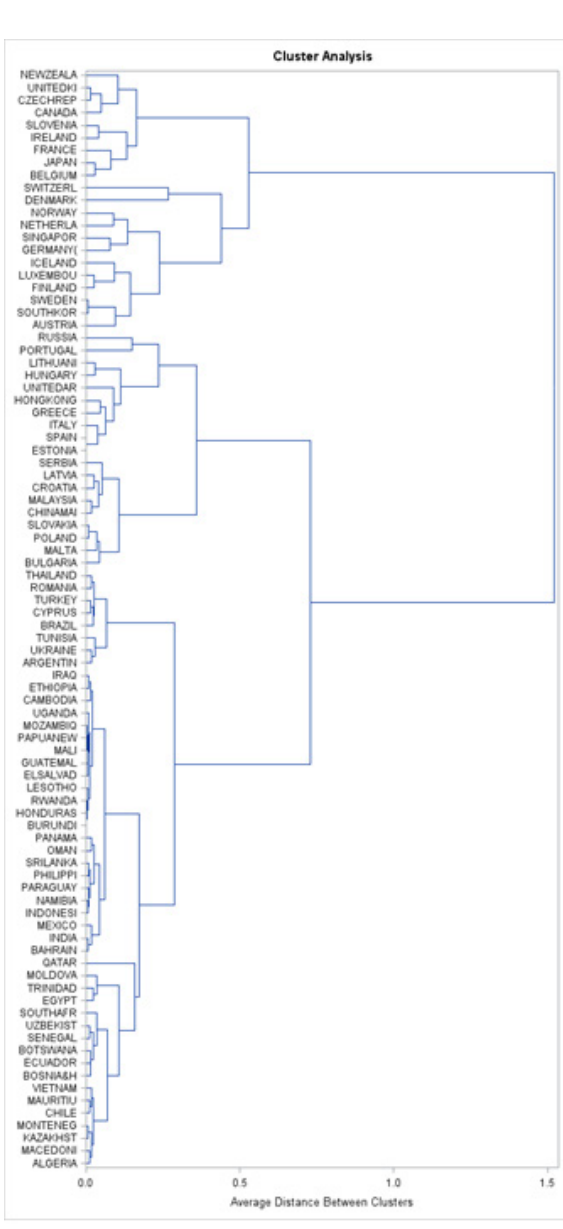
Figure 3. Dendrogram for country clusters formed by financing (GERD/cap and GERD/GDP). Seven clusters were significant. The X-axis indicates the distance between cluster nodes. Countries that join together sooner are more similar than those that join